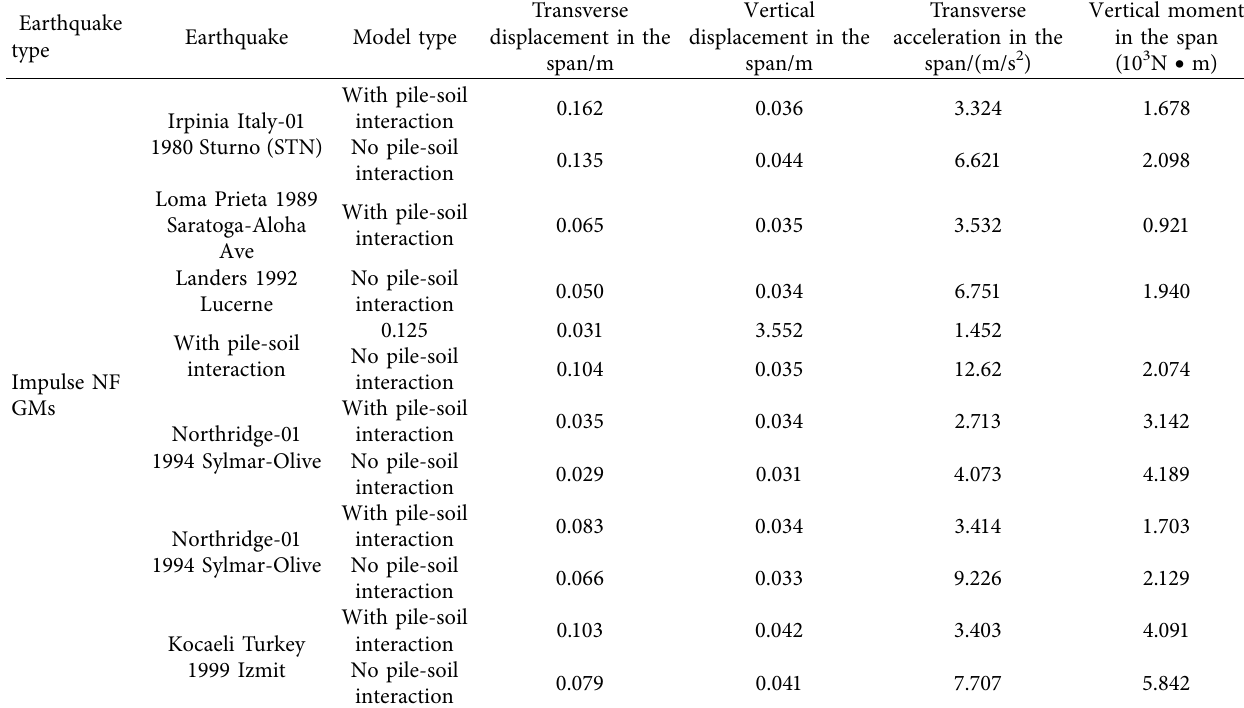
Table 5: Summary of peak seismic response of continuous girder bridge of high-speed railroad under the action of rare impulse-type NF